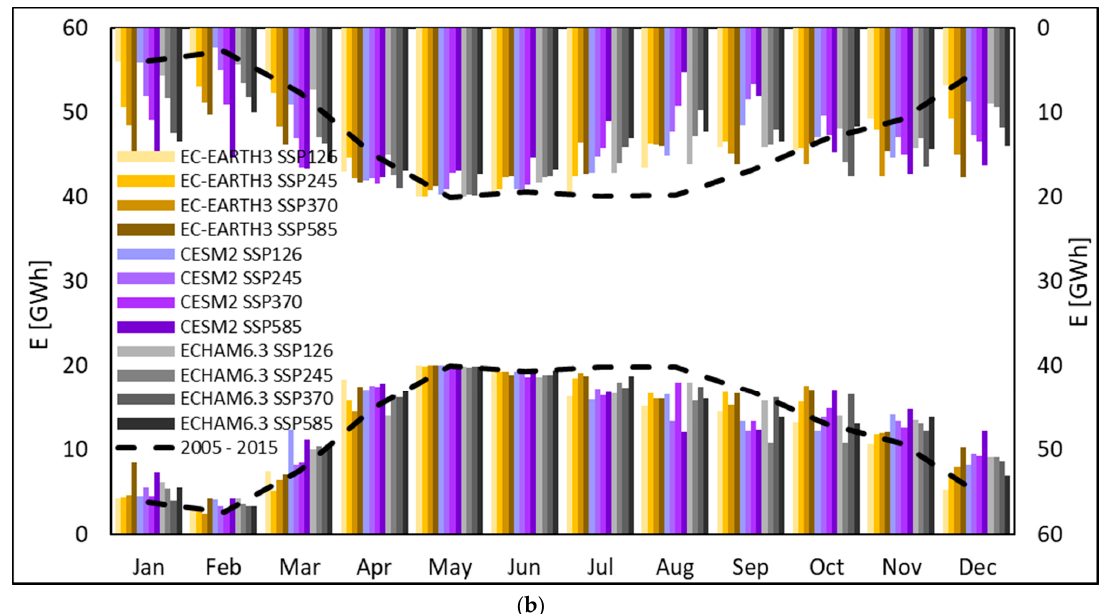
Figure 4. Mean projected monthly incoming discharge E (GWh) at the Chavonne plant. In the left y axis, we reported monthly E during the period P1, 2040–2049. In the right y axis, i.e., with the uppermost bars, with values to be read upside-down, we reported monthly E during the period P2, 2090–2099. We also report control run (2005–2015, black dashed line). ( a ) GCMs: Ec-Earth, CCSM4, ECHAM6.0. Scenarios: RCP 2.6, RCP 4.5, RCP 8.5. ( b ) GCMs: Ec-Earth3, CESM2, ECHAM6.3. Scenarios: SSP1